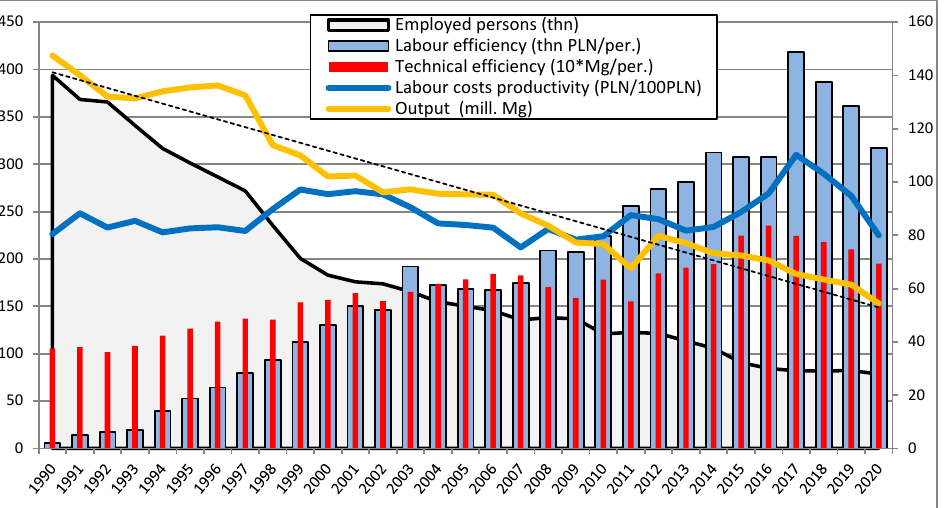
Figure 2. Employed persons, labour efficiency and labour costs productivity of coal mining enter- prises in 1990 – 2020. Note: output and technical efficiency — right axis. Source: as in Figure 1.